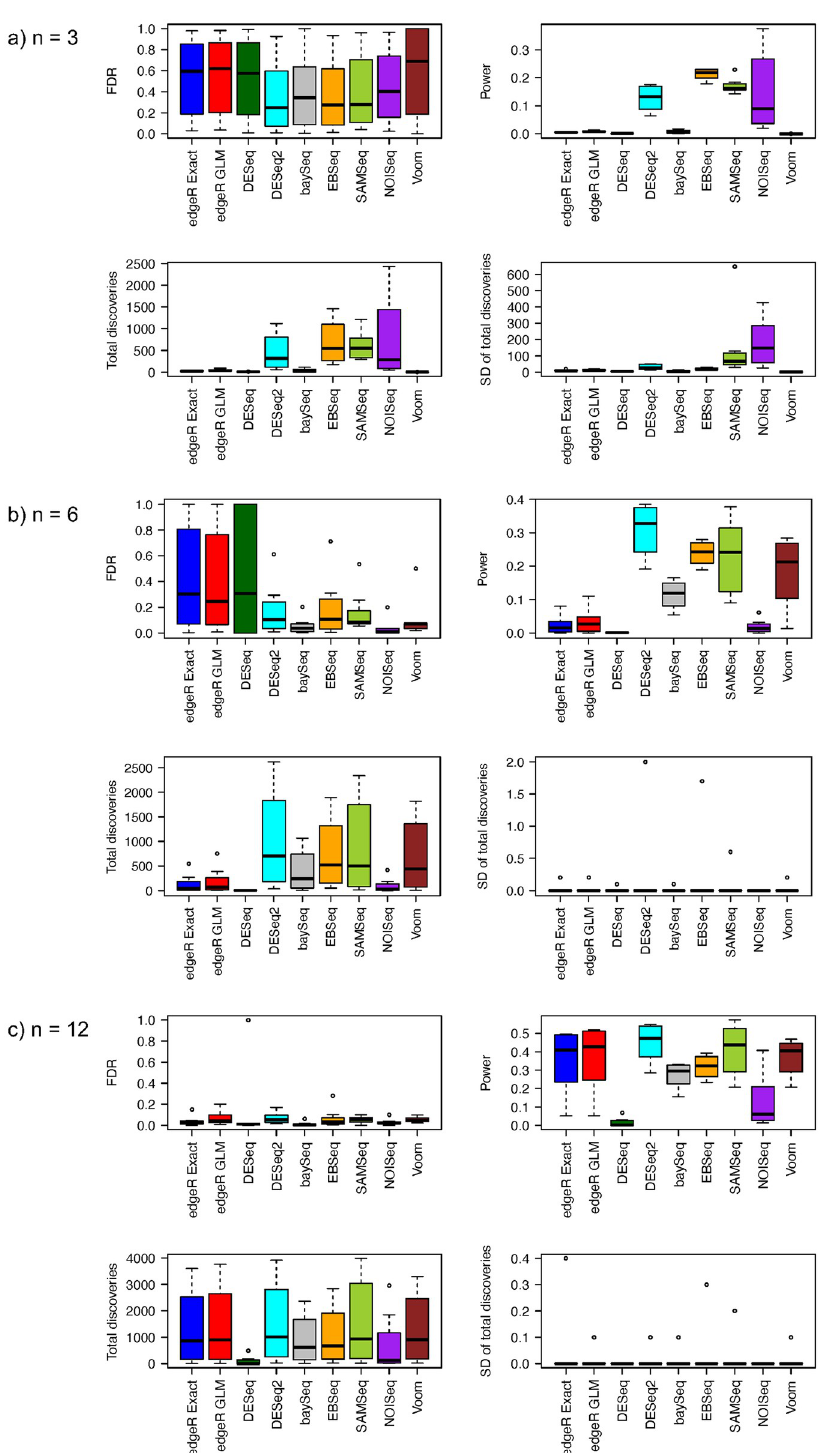
Fig 1. Estimated FDRs, powers, means of total discoveries, and SD of total discoveries from different RNA-Seq differential analysis methods with negative binomial distribution assumption and equal library size for a) n = 3, b) n = 6, and c) n =